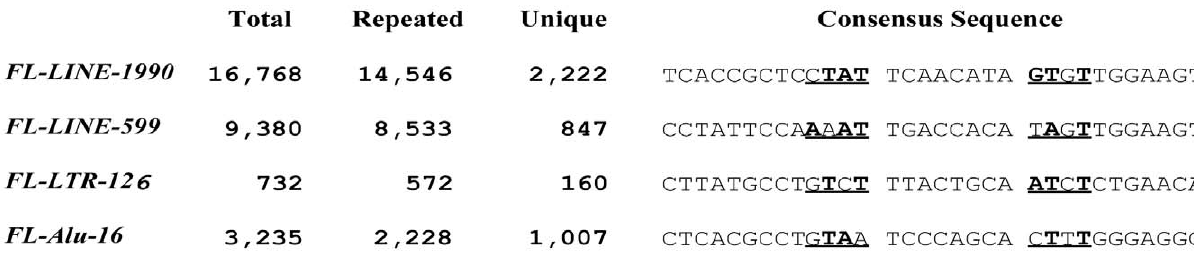
Figure 7. Distribution of some FRT -like sequences originated in repeated DNA elements between repeated and unique pools. FL- LINE-1990 and Fl-LINE-599 represent groups of the FRT -like sequences that originate at positions 1990 and 599 of ORF2 of LINE1, respectively (see Figure 6). FL-LTR-126 represents a group of the FRT -like sequences that originate at position 126 of LTR of transposon MER11a (Figure 6). FL-Alu-16 represents a group of the FRT -like sequences that originate at position 16 of the left half of Alu sequence (Figure 6). Consensus sequence for FL-Alu-16 has 33 nucleotides; red ‘‘X’’ indicates any nucleotide.